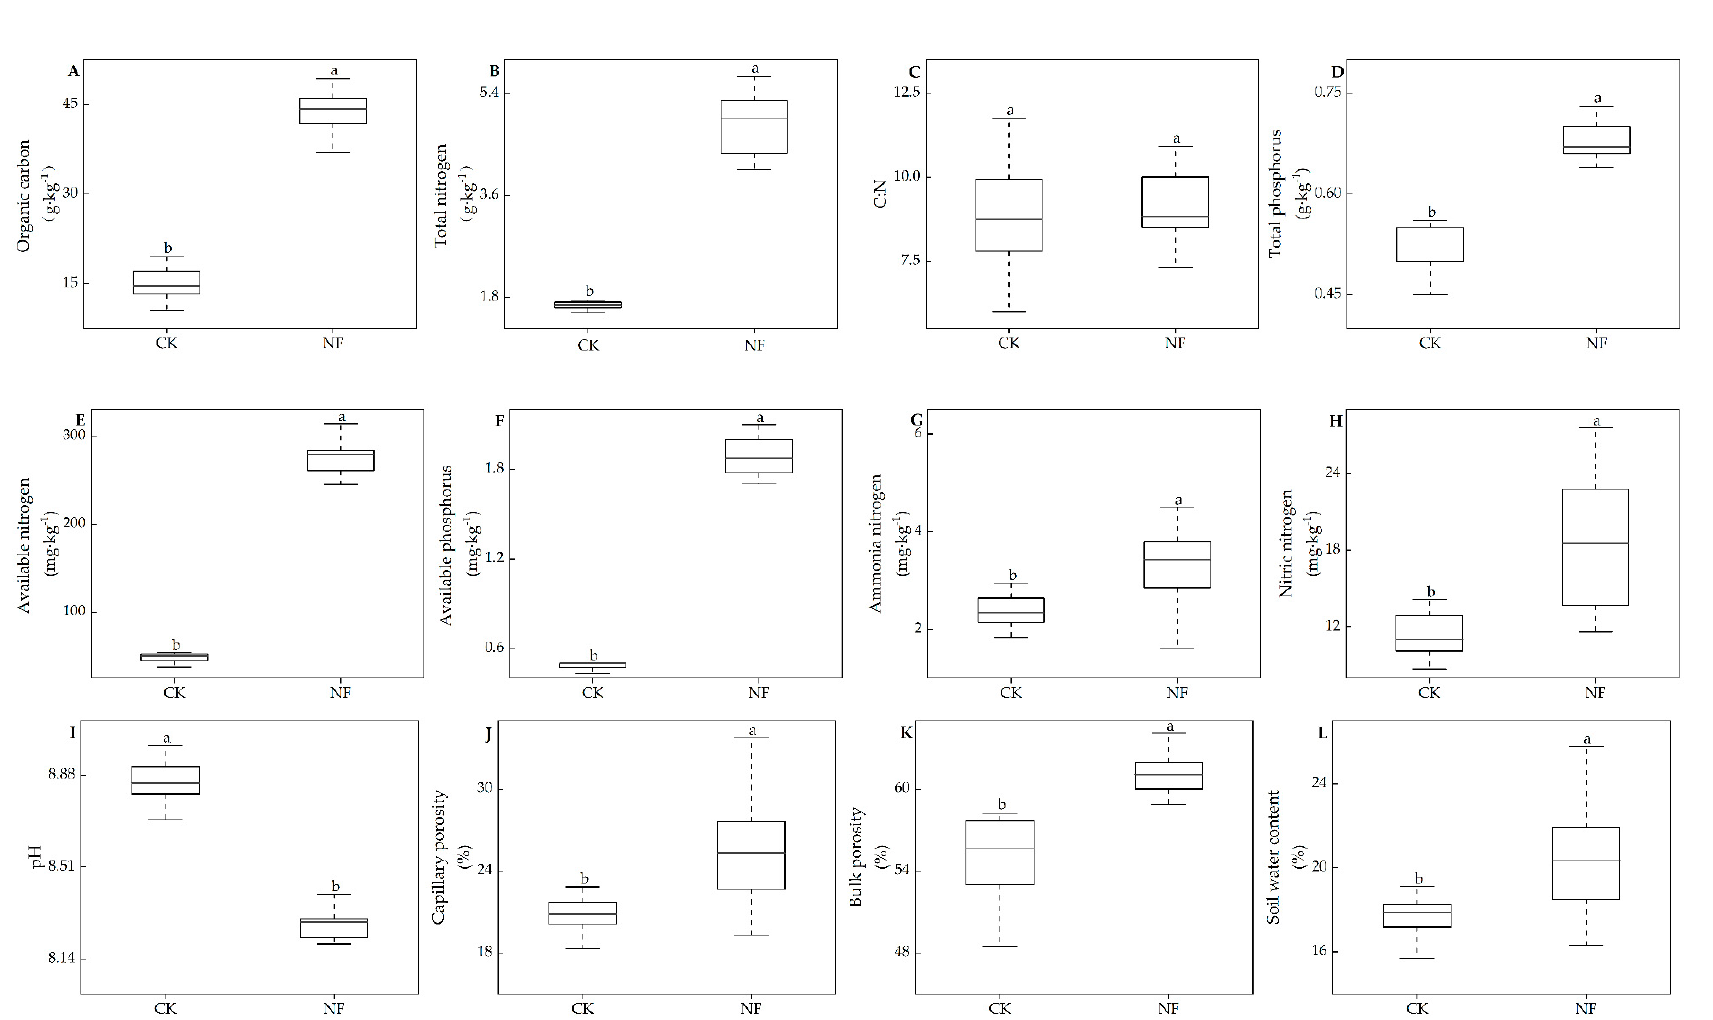
Figure 2. Effects of main land-use types on single ecosystem functions. ( A ), organic carbon; ( B ), total nitrogen; ( C ), C:N; ( D ), total phosphorus; ( E ) available nitrogen; ( F ), available phosphorus; ( G ), ammonia nitrogen; ( H ), nitric nitrogen; ( I ), pH; ( J ), capillary porosity; ( K ) bulk porosity; ( L ), soil water content. a/b: Different lowercase letters represent significant differences between NF and CK ( p < 0.05).